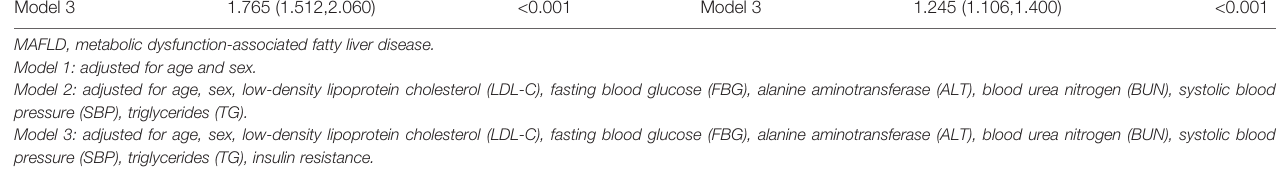
Model 3: adjusted for age, sex, low-density lipoprotein cholesterol (LDL-C), fasting blood glucose (FBG), alanine aminotransferase (ALT), blood urea nitrogen (BUN), systolic blood pressure (SBP), triglycerides (TG), insulin resistance.